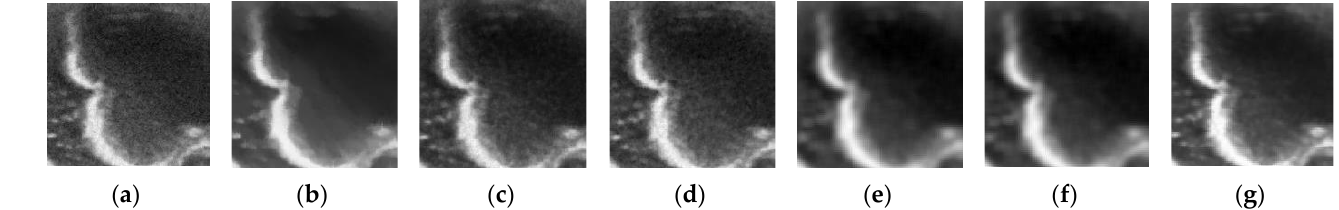
Figure 10. Magnified image of vitreous mechanization in part of the lesion. ( a ) Noise image. ( b ) TV